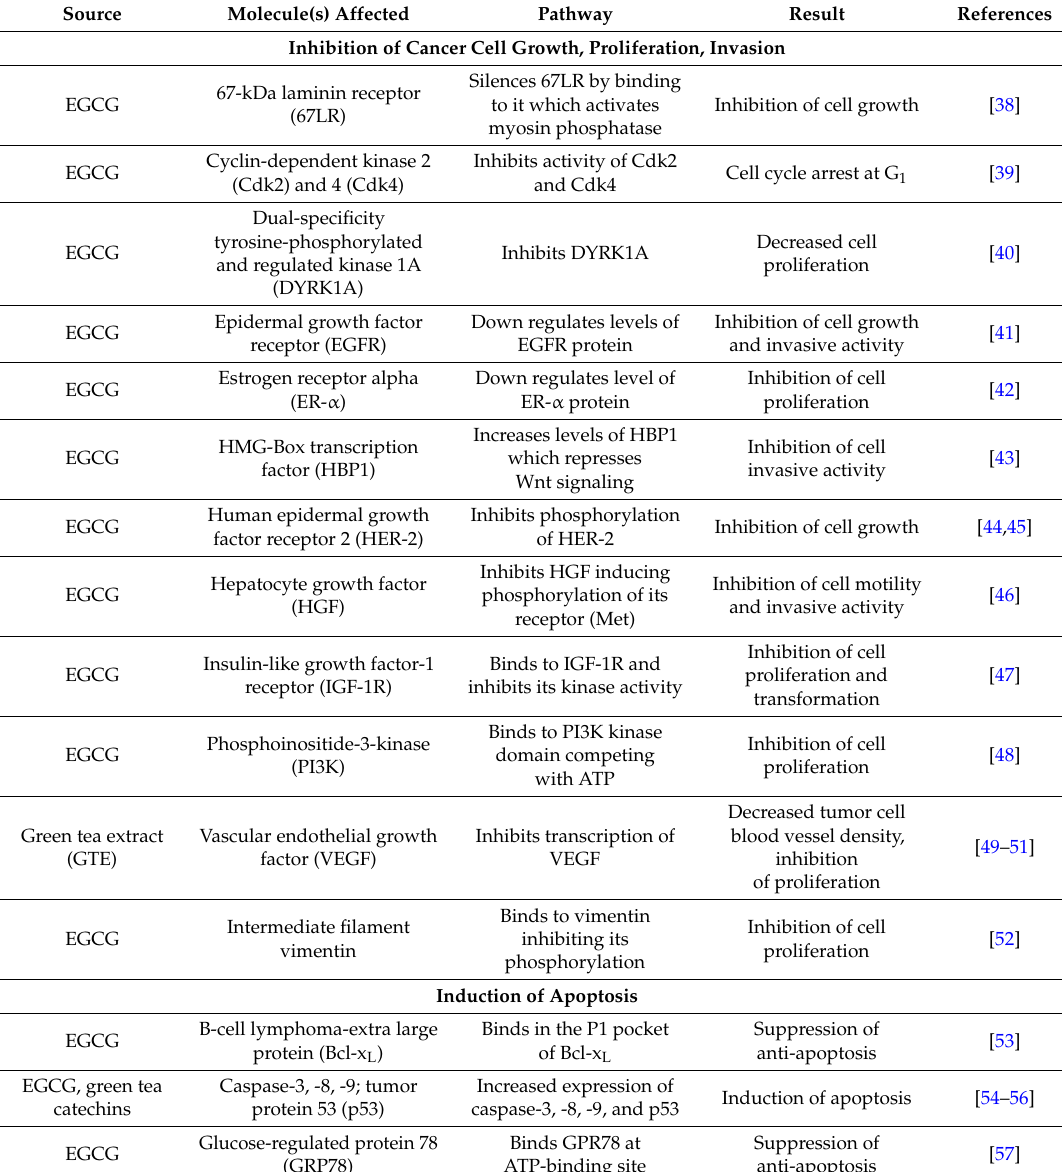
Table 2. Potential targets and mechanisms of green tea catechins in breast